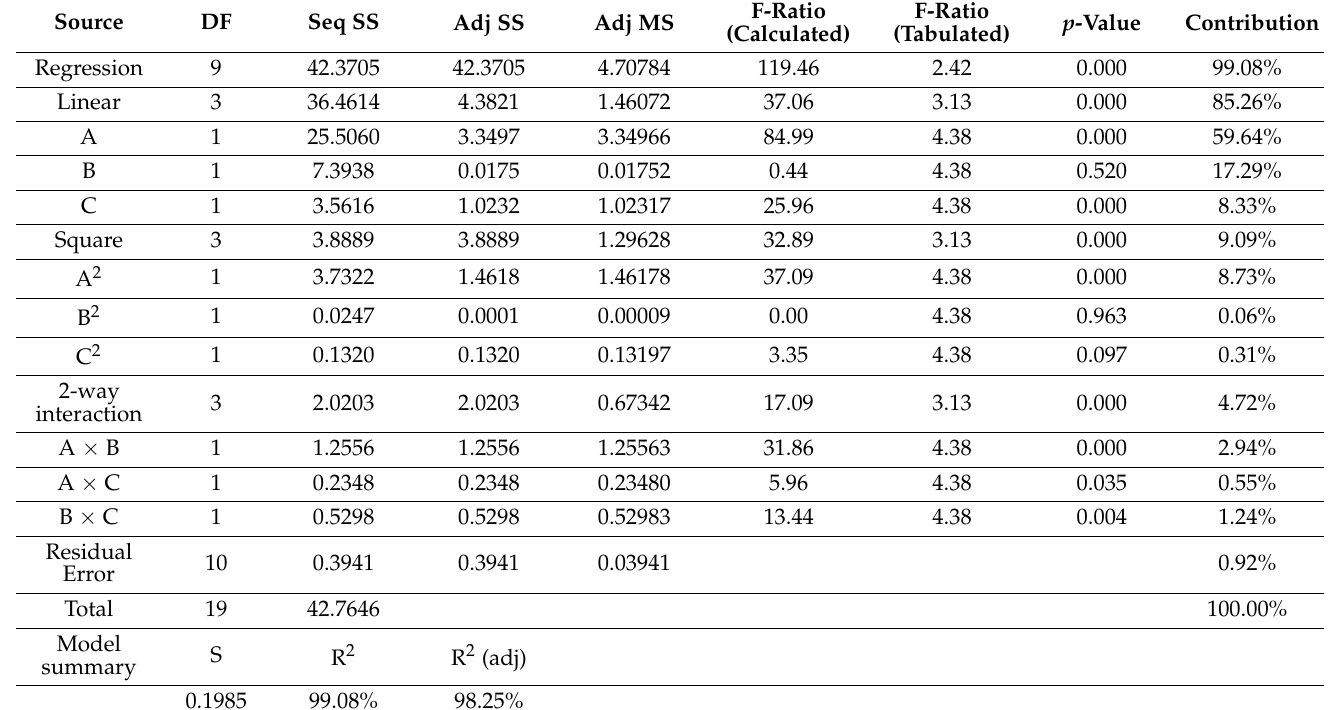
Table 8. ANOVA for surface roughness of carbon fabric-neat